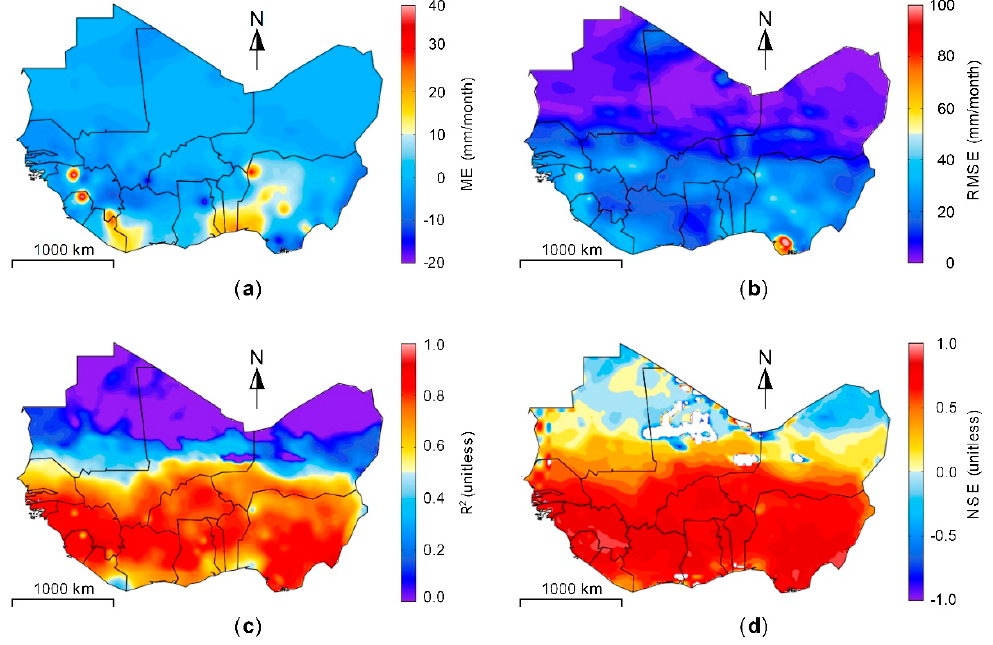
Figure 7. Validation of ANN backcasted GRACE-derived TWSC ANN over WA ( a ) Mean error—ME; ( b ) Root-mean-square error—RMSE; ( c ) Coefficient of determination— R 2 ; and ( d ) Nash-Sutcliffe efficiency coefficient—NSE.